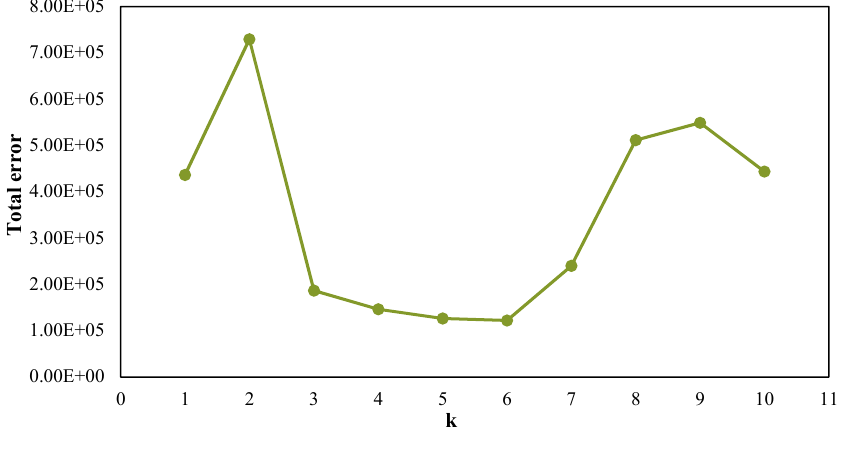
Figure 6. Total error